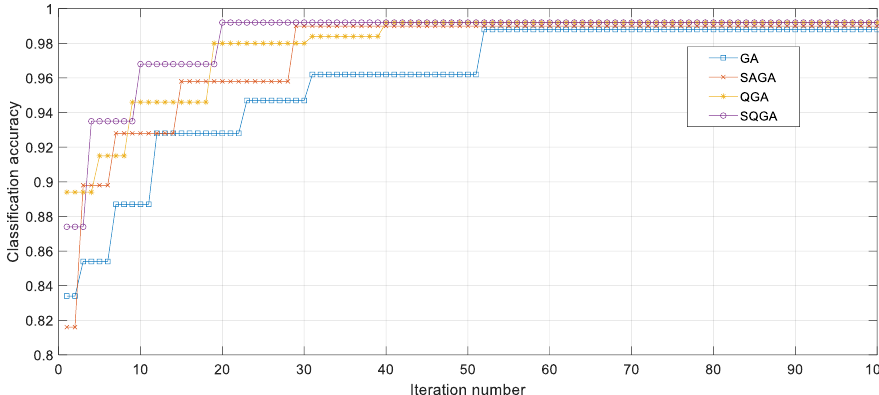
Figure 6. Optimization results from different methods.